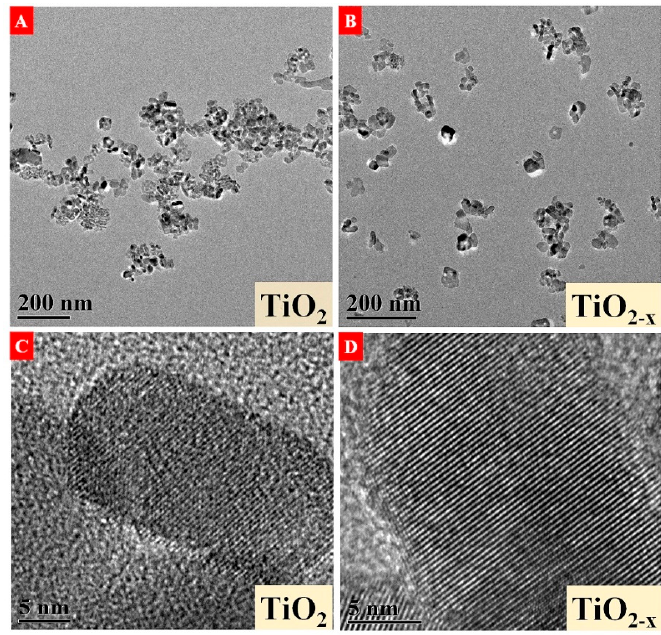
Figure 4. TEM images of ( A , C ) pristine TiO 2 and ( B , D ) gray TiO 2 − x .